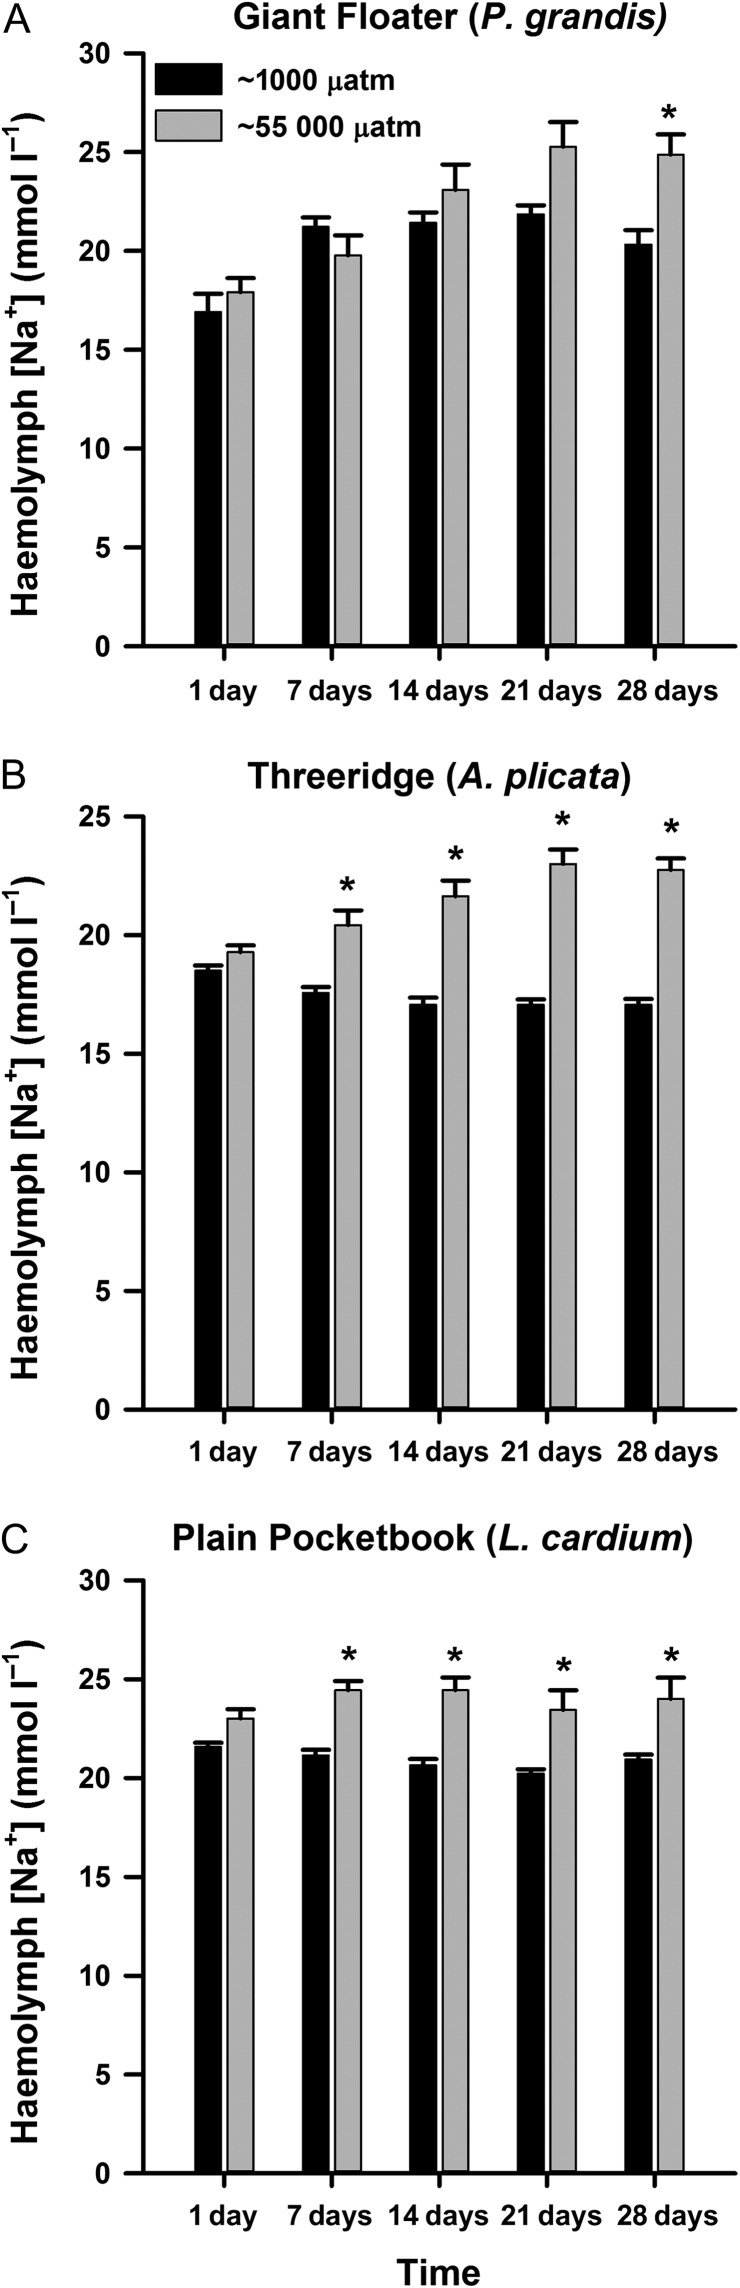
Concentrations of Na+ in the haemolymph of Pyganodon grandis (n = 9–14; A), Amblema plicata (n = 12–14; B) and Lampsilis cardium mussels (n = 13–14; C) exposed to two treatments of pCO2, ~1000 µatm (control) or intermittent increase at ~55 000 µatm for 1, 7, 14, 21 or 28 days. Data are presented as means + SEM. *Groups that were significantly different from the control treatment within a time point (two-way ANOVA; see Tables 2–4).